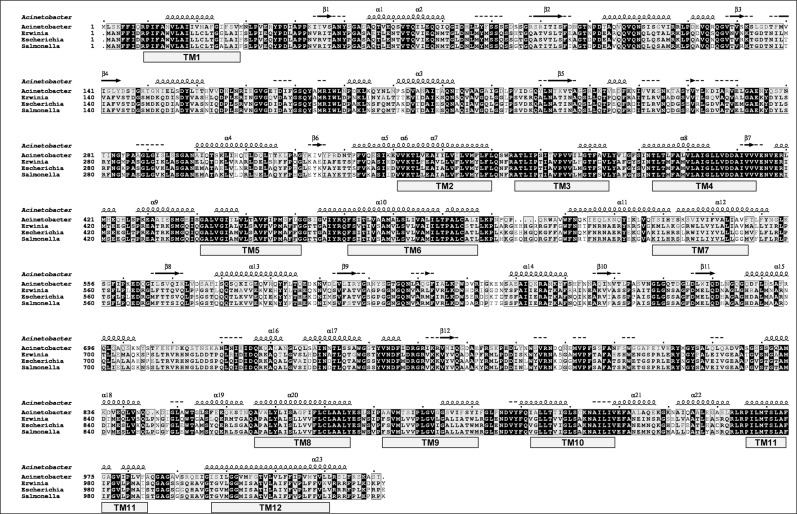
Alignment of multiple AbeD sequences and its homologs.Sequence alignments were made in CLUSTAL Omega (https://www.ebi.ac.uk/Tools/msa/clustalo) and formatting using the ESPript server (http://espript.ibcp.fr/ESPript/cgi-bin/ESPript.cgi). The accession numbers of AbeD from A. baumannii is CAM85780.1, Erwinia amylovora ATCC 49946 is YP_003539485.1, Escherichia coli is YP_490697.1, and Salmonella enterica serovar Typhimurium is ADX18241.1. The predicted secondary structural elements of A. baumannii AbeD are shown on the lines above the sequence alignment using PSIPRED (http://bioinf.cs.ucl.ac.uk/psipred). Transmembrane regions TM1 to TM12 were predicted using HMMTOP (http://www.enzim.hu/hmmtop/index.php). The arrows indicate β-sheet and the coils indicate α-helices respectively. Residues strictly conserved have a black background and is indicated by bold letters; residues conserved between groups are boxed.